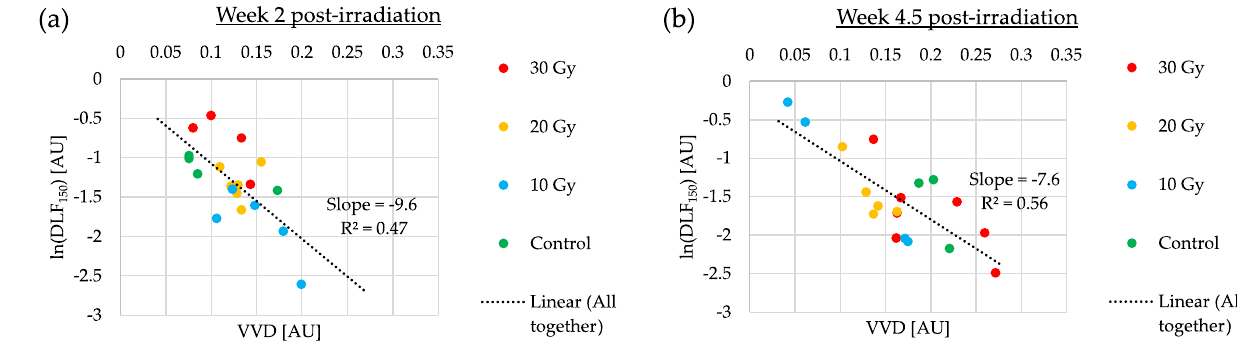
Figure 5. The diffusion-limited fraction DLF 150 versus vascular volume density VVD metrics at two timepoints